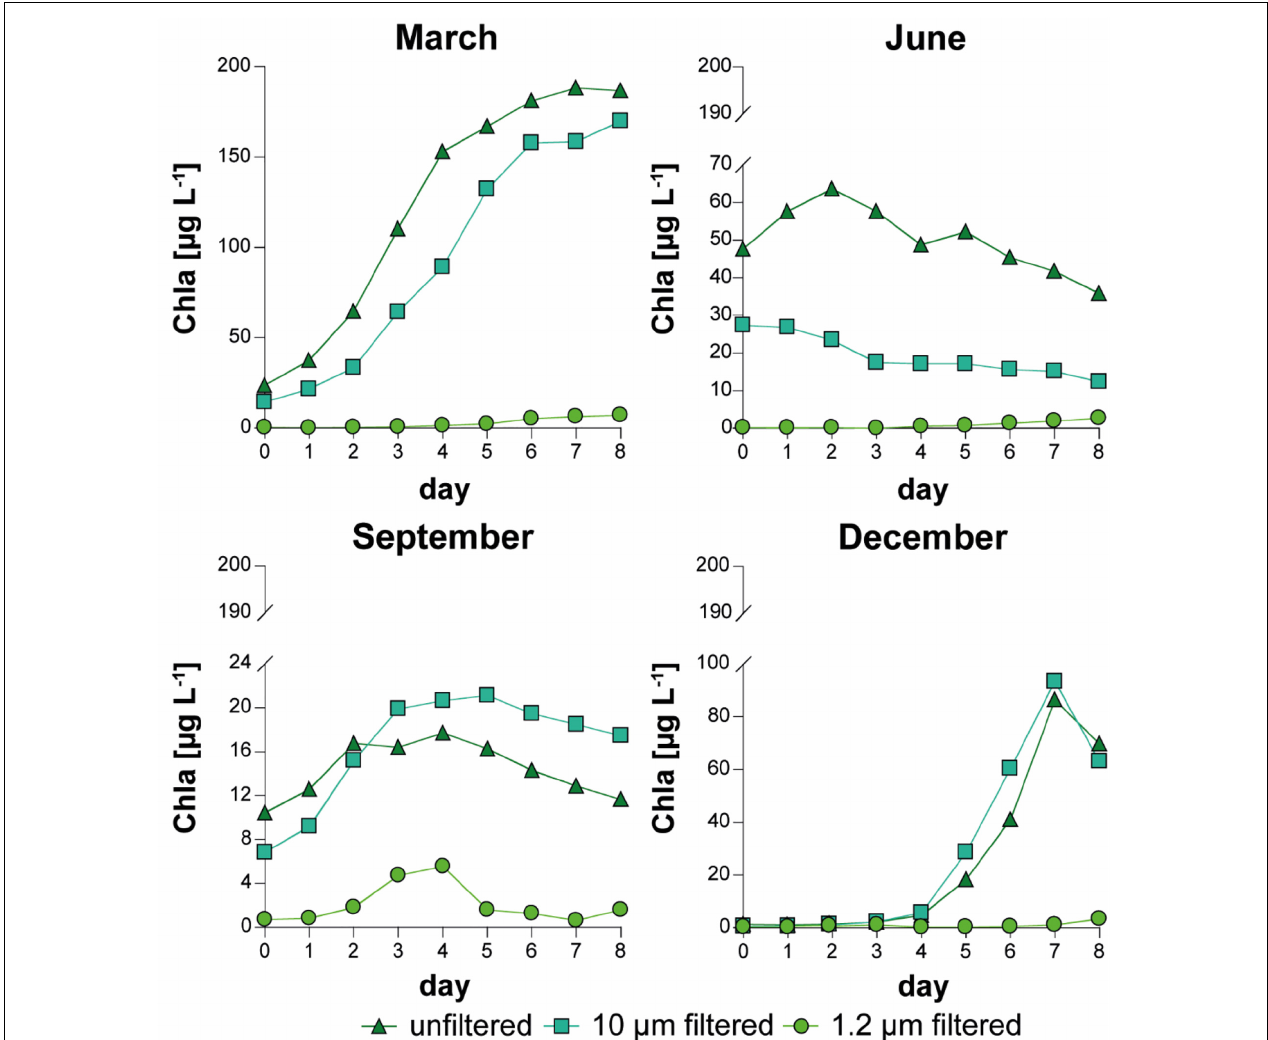
FIGURE 2 | Variation in chlorophyll a (Chla, median of triplicates) in all treatments and